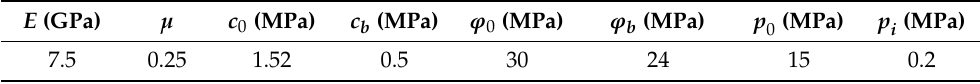
Table 1. Mechanical parameters of roadway surrounding